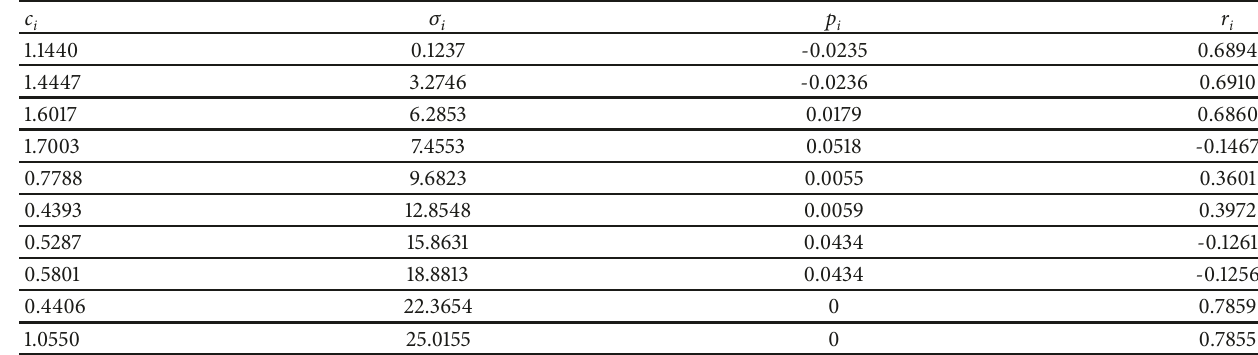
Table 2: Parameters of the ANFIS after training for the 1 st joint (Case 2).